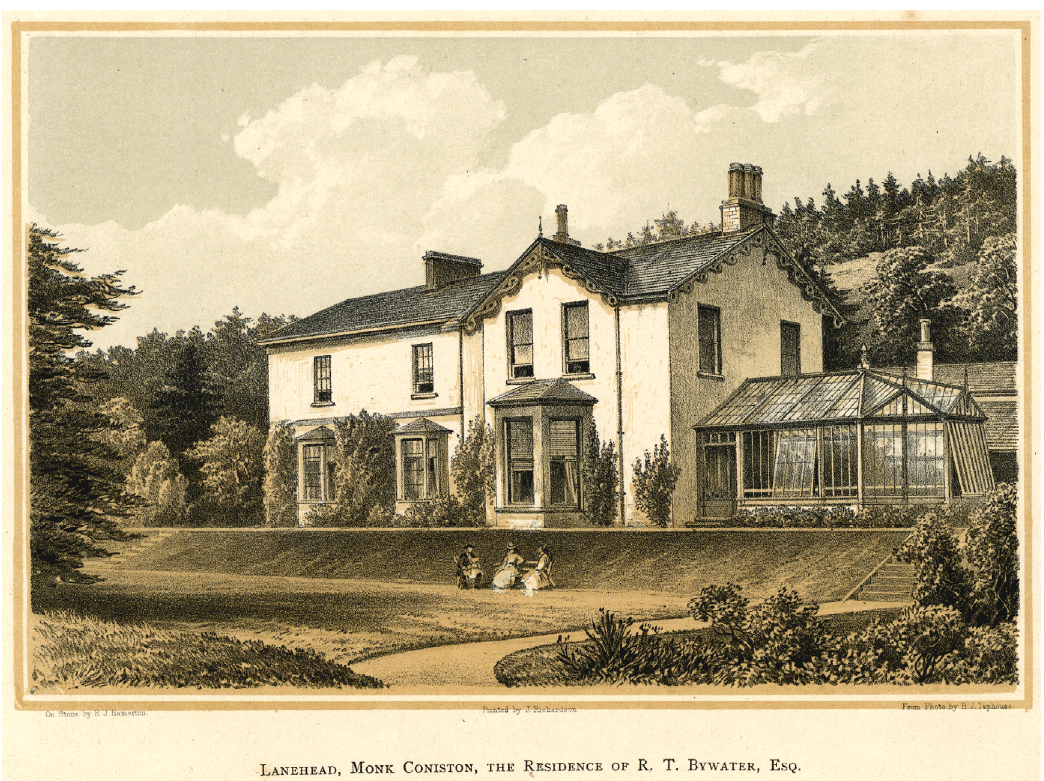
Figure 1. Lanehead (Courtesy of Jean and Martin